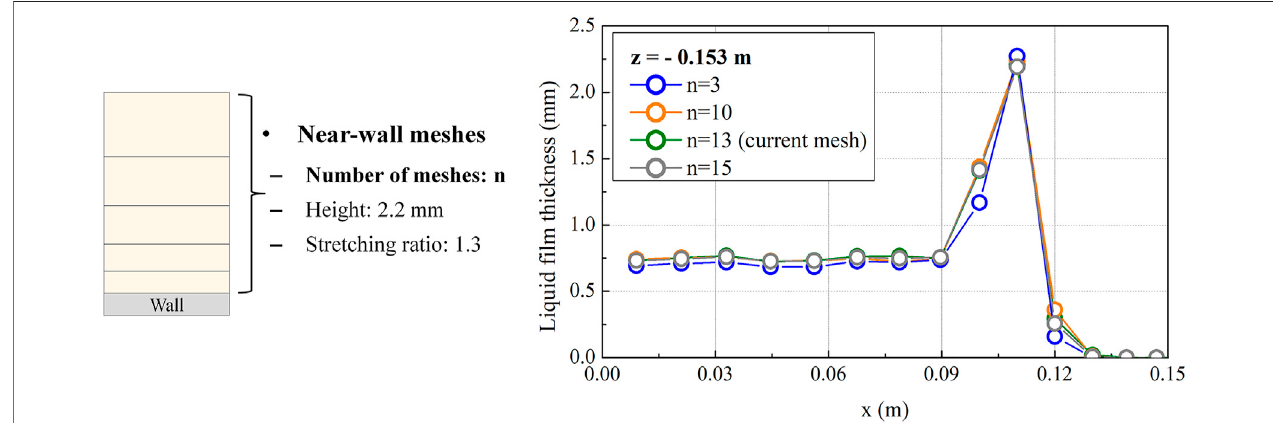
FIGURE 6 | Sensitivity test for near-wall meshes.